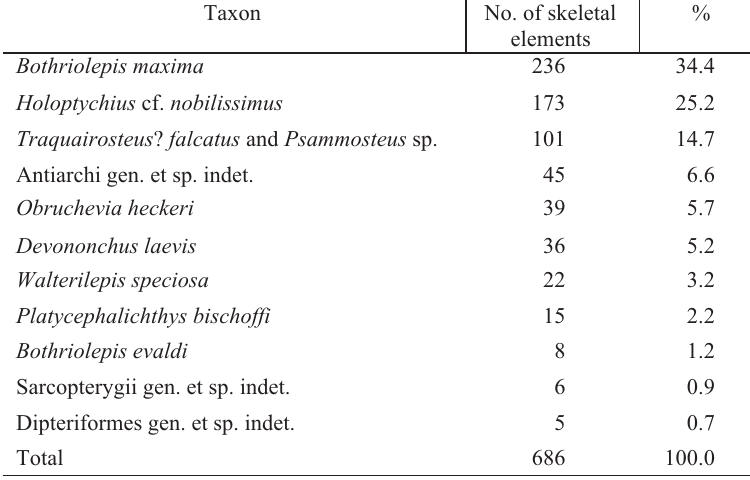
Table 3. Number and percentage (%) of skeletal elements from the Gurova